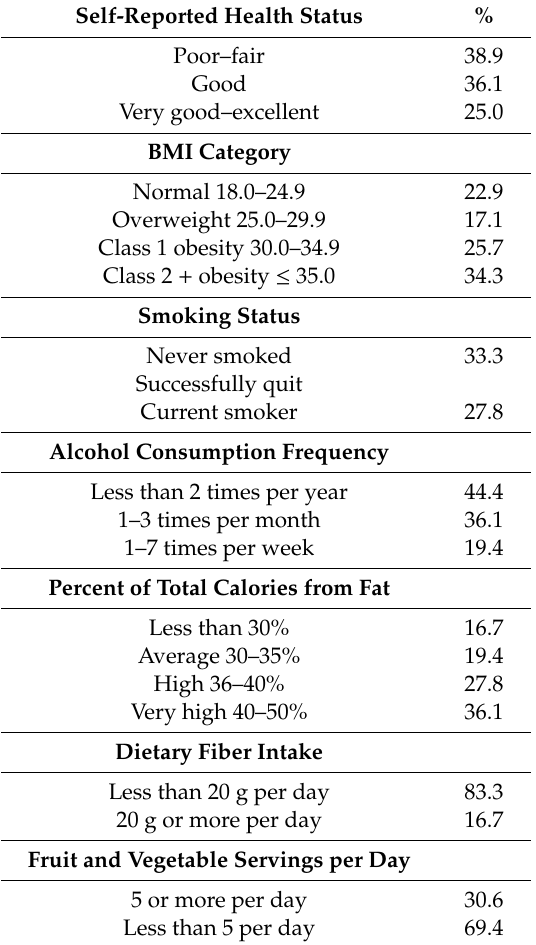
Table 2. Health characteristics and risk factors of low-socioeconomic Iowa women ( n =